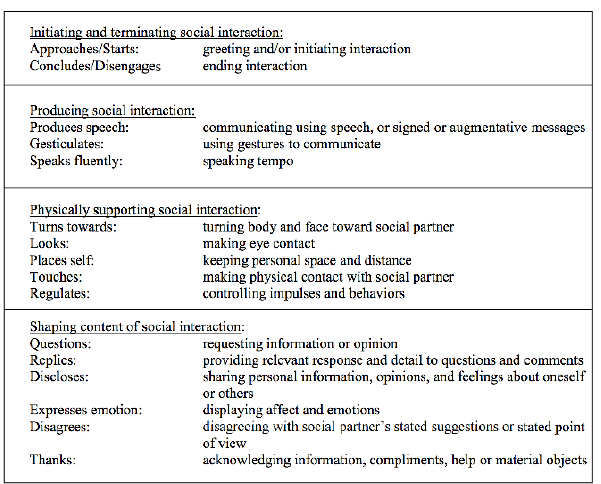
Table 6. Social interaction skills found on evaluation of social interaction (Fisher&Griswold, 2008)